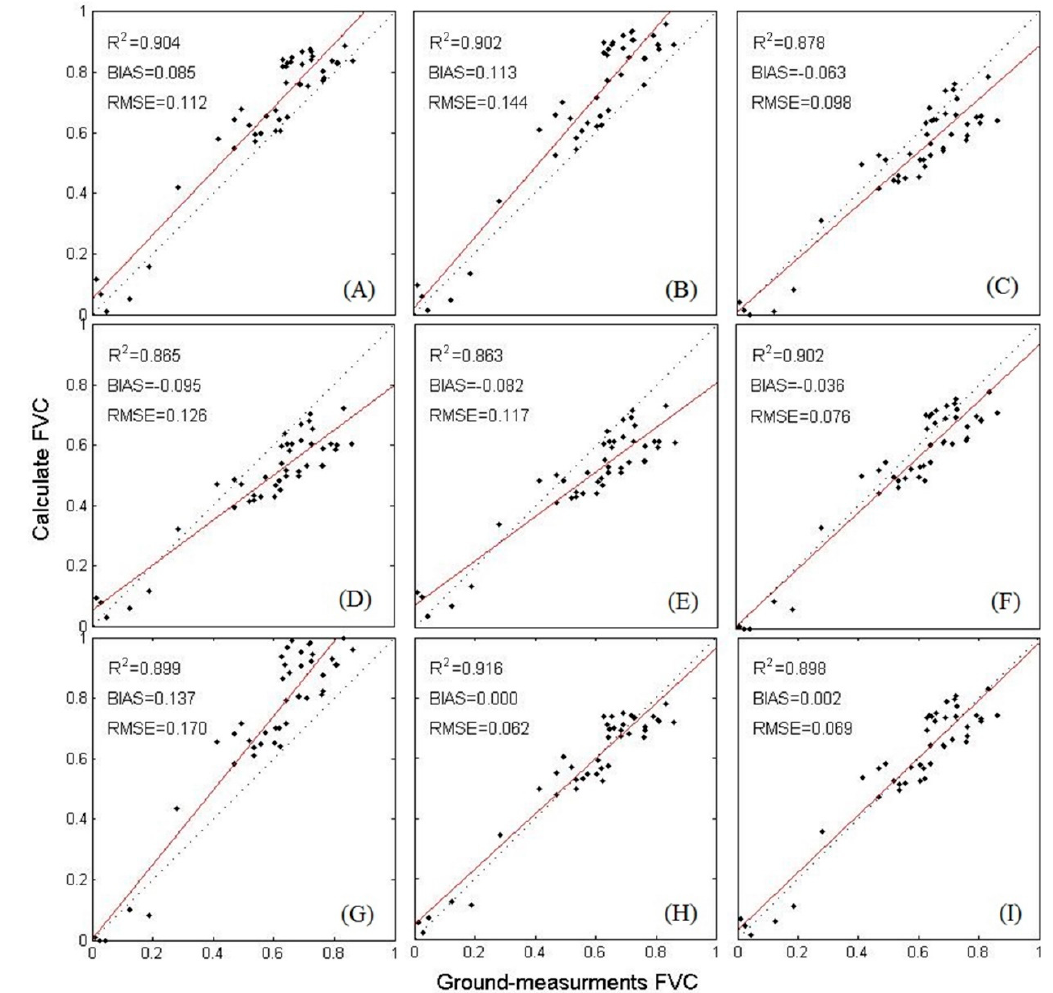
Figure 5. Accuracy assessment of the individual models and the two (MLR and BMA) combination methods. ( A ) Pixel dimidiate model using NDVI; ( B ) Pixel dimidiate model using EVI; ( C ) TGDVI; ( D ) MTGDIV1; ( E ) MTGDVI2; ( F ) SMA3 model and ( G ) SMA4 model; ( H ) MLR method using seven individual models; ( I ) BMA method using seven individual